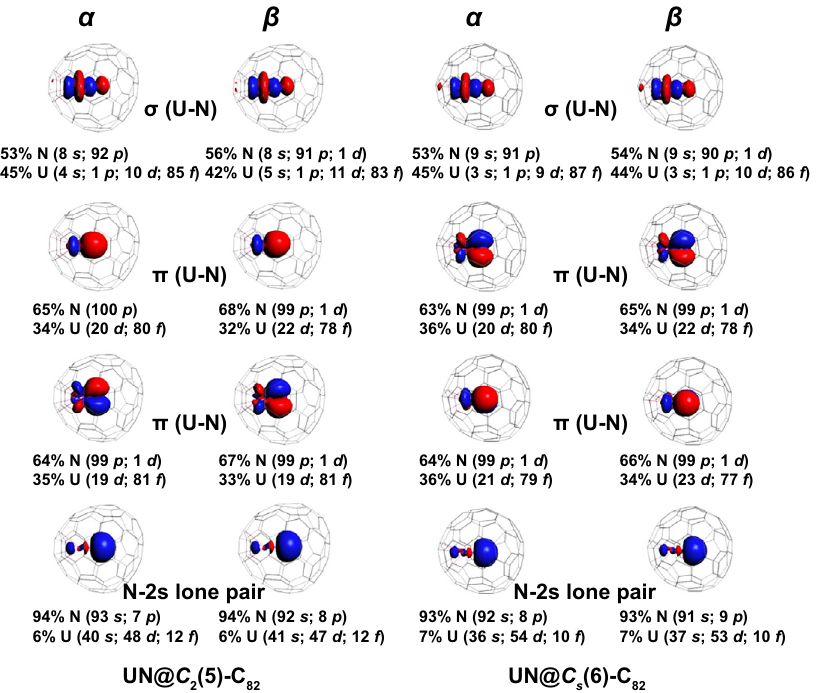
Fig.5|NLMOsandatomicorbital%-weightsfortheU ≡ Ntriplebond. NLMOs(±0.03a.u.isosurfaces)andatomicorbital%-weightsforthespin-doubletgroundstatesof UN@ C 2 (5)-C 82 (left) and UN@ C s (6)-C 82 (right). Alpha ( α )- and beta ( β )-spin orbitals are plotted